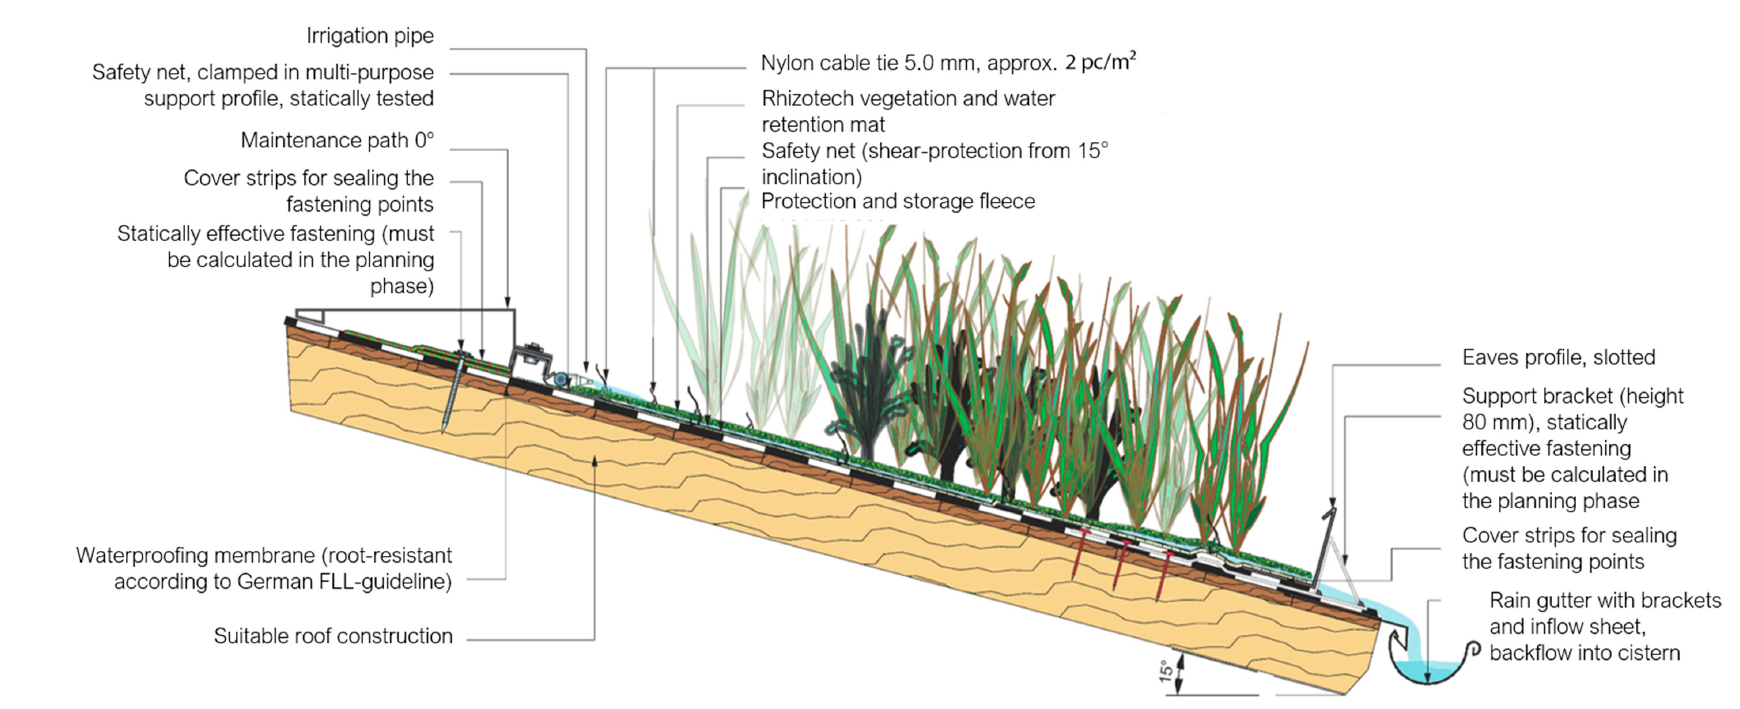
Figure 2. Basic structure of a wetland roof, as already realized in practice (graphic: Michael Blumberg).